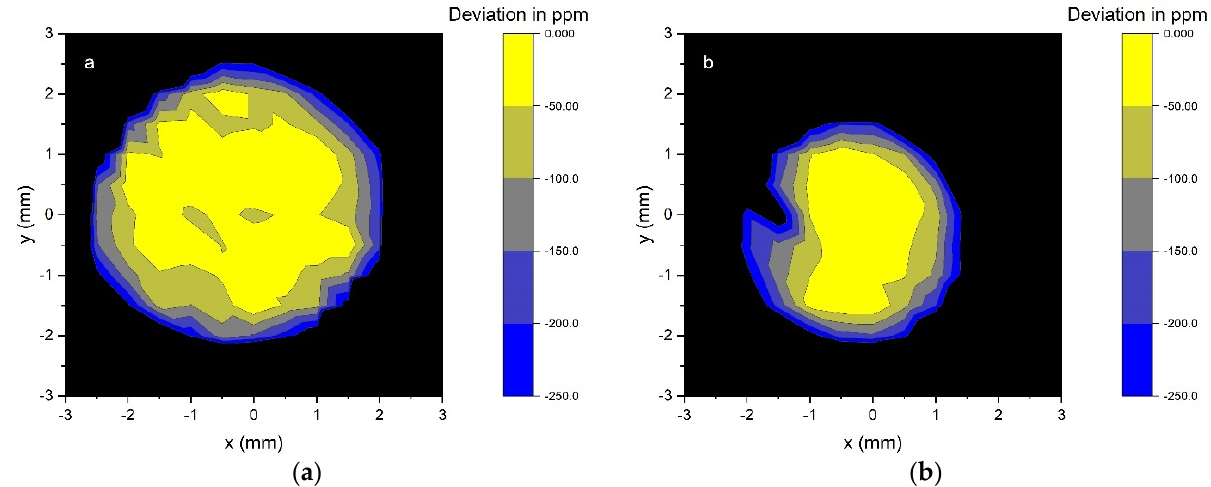
Figure 16. Spatial uniformity of optical power responsivity of the PQEDs with SiO 2 /SiN x stack photodiodes P18-55-45 ( a ) and P18-54-44 ( b ).